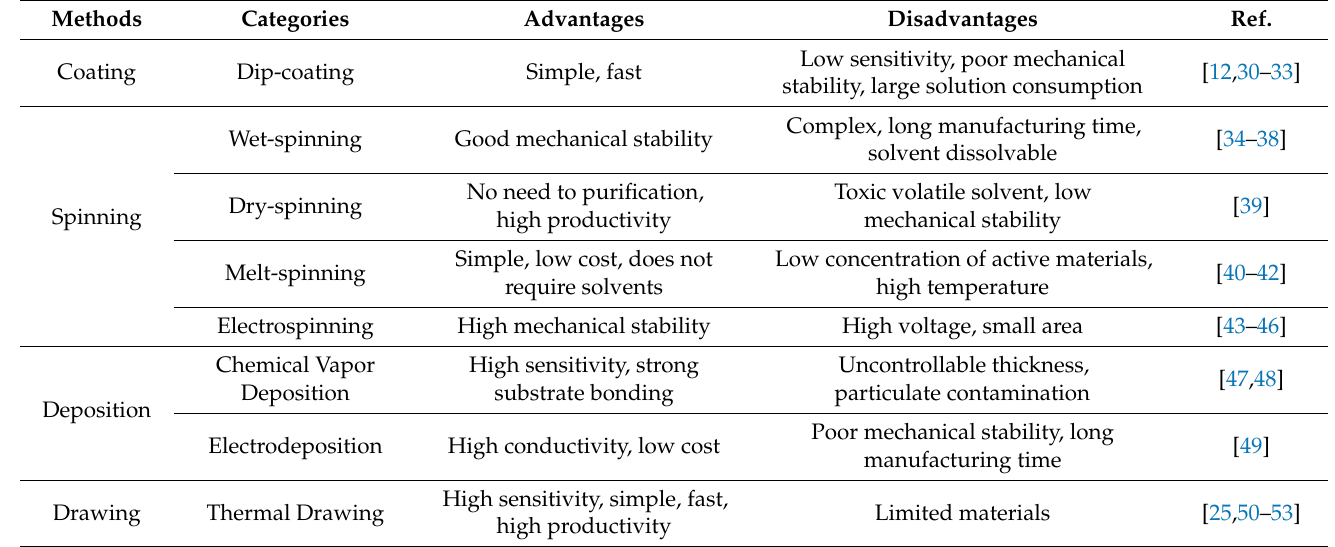
Table 1. Comparison of common fabrication methods for fiber-based